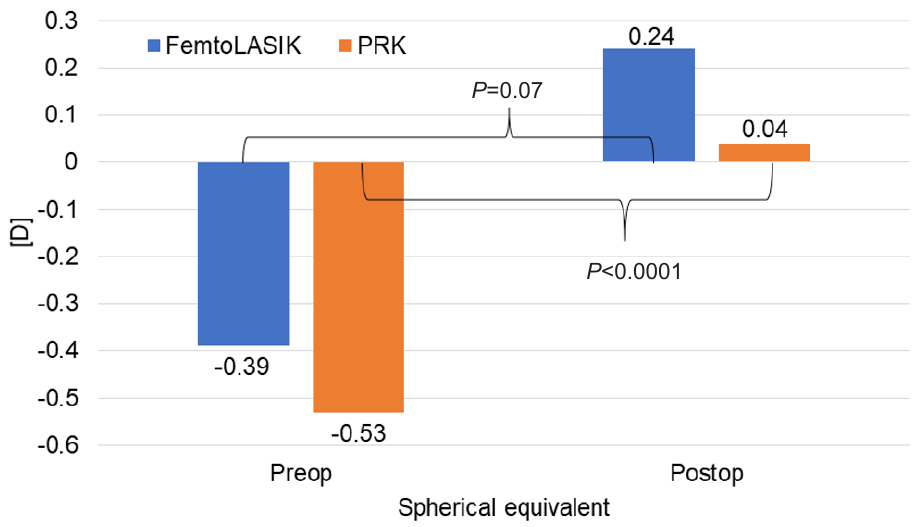
Fig. 3. Evaluation of spherical equivalent in diopters (D) in FemtoLASIK and PRK